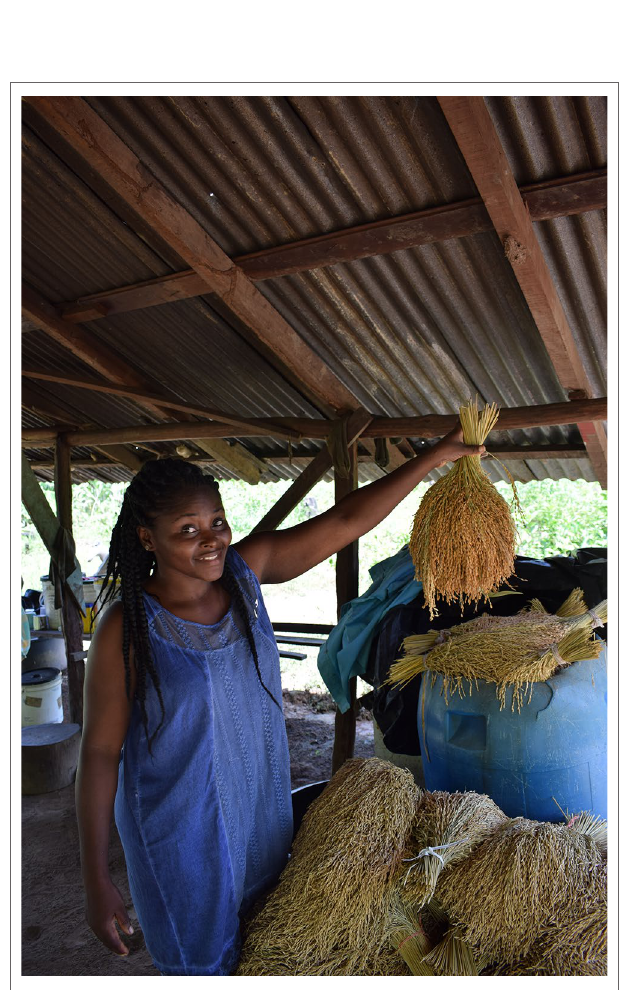
FIGURE 2 | Harvesting ripe panicles by hand near Bigiston, lower Maroni River. Picture by Alice Bertin. Written informed consent was obtained for the publication of this